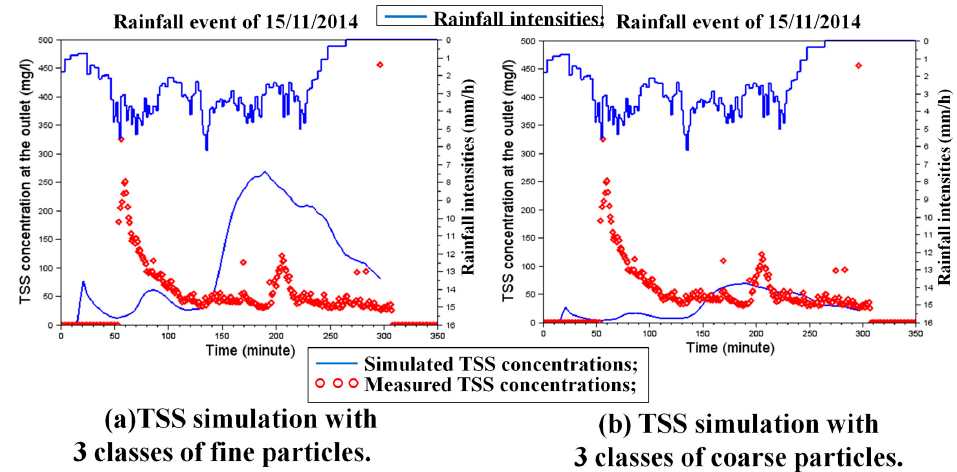
Figure 12. Water quality simulations with different Particle Size Distributions for ( a ) three classes of fine particles derived from PSD of stormwater samples: 3.5 μ m, 15 μ m, 50 μ m; ( b ) three classes of coarse particles derived from PSD of dry stock samples: 7 μ m, 70 μ m, 250 μ m. The simulated TSS concentrations at the outlet (solid blue line) are compared with the measured data (red circles). Rainfall is plotted on the upper